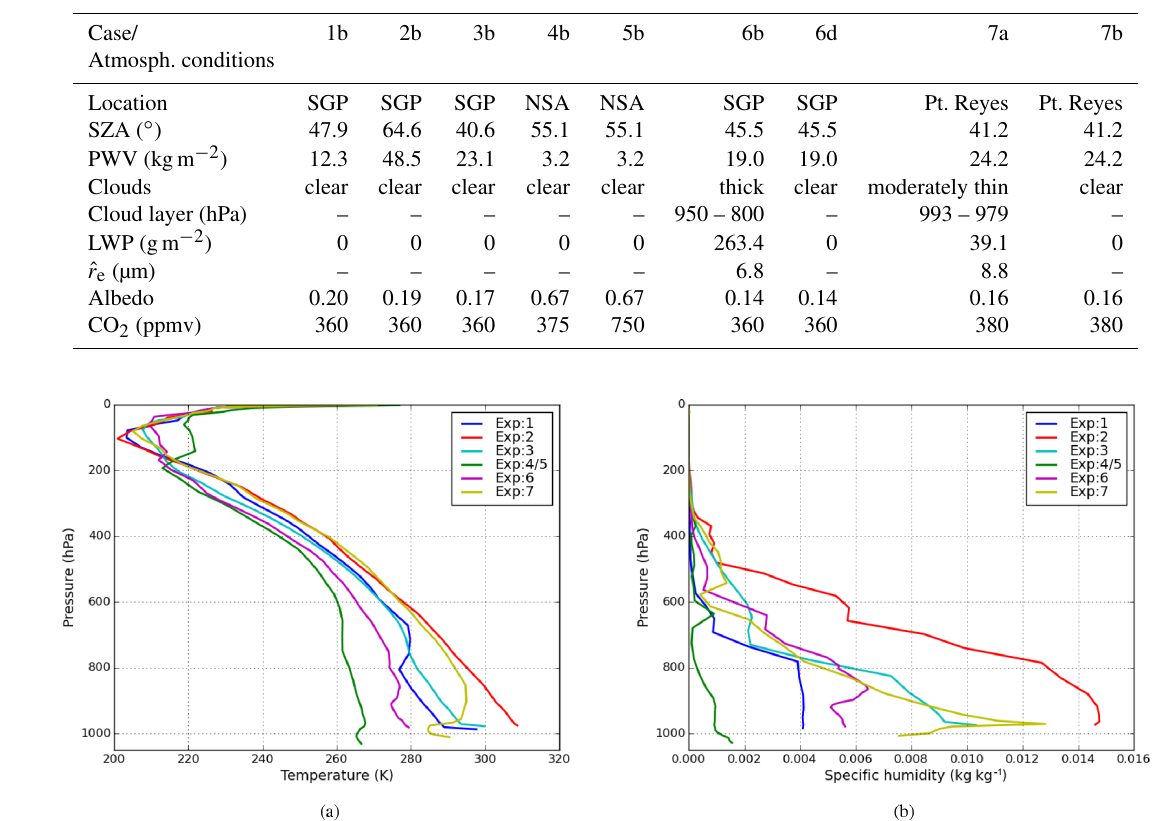
Figure 1. Input (a) temperature (K) and (b) specific humidity (kgkg − 1 ) profiles for the 7 CIRC cases.